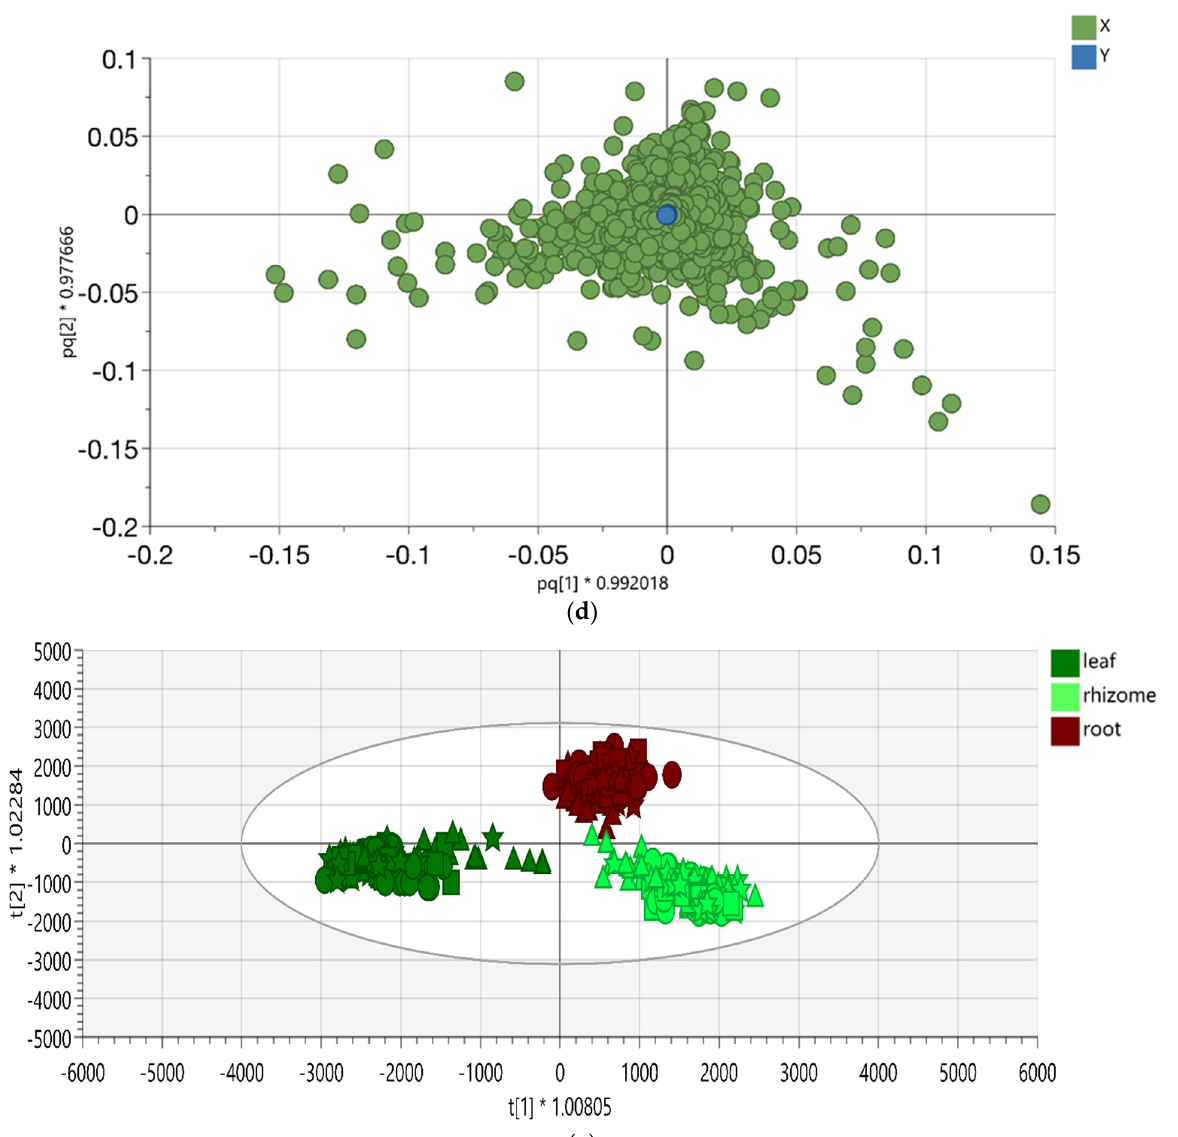
Figure 2. ( a ) The OPLS-DA score plot of different Phragmites australis extracts with a confidence limit of 95% discriminating according to the solvent used in the extraction. The variables were plotted according to the first principal component (t1) and the orthogonal component (t2). The triangles represent 100% methanol extracts, circles represent acidic 90% methanol extracts, the squares represent 50% methanol extracts and the stars represent aqueous extracts, respectively. The green color represents leaf samples, the light green color represents rhizome samples and the brown color represents root samples, respectively. Each symbol represents one observation of P. australis leaf, rhizome and root plant part; ( b ) loading scatter plot for the selected principal components; ( c ) the Q 2 /R 2 Overview plot displays the individual cumulative R 2 (green columns) and Q 2 (blue columns) for the goodness of fits and cross-validation parameters; ( d ) the loading scatter plot for the selected principal components displays the relation between the different Phragmites australis samples and the chosen metabolites; ( e ) the OPLS-DA score plot of the different parts of Phragmites australis with a confidence limit of 95%, discriminating according to the plant part.